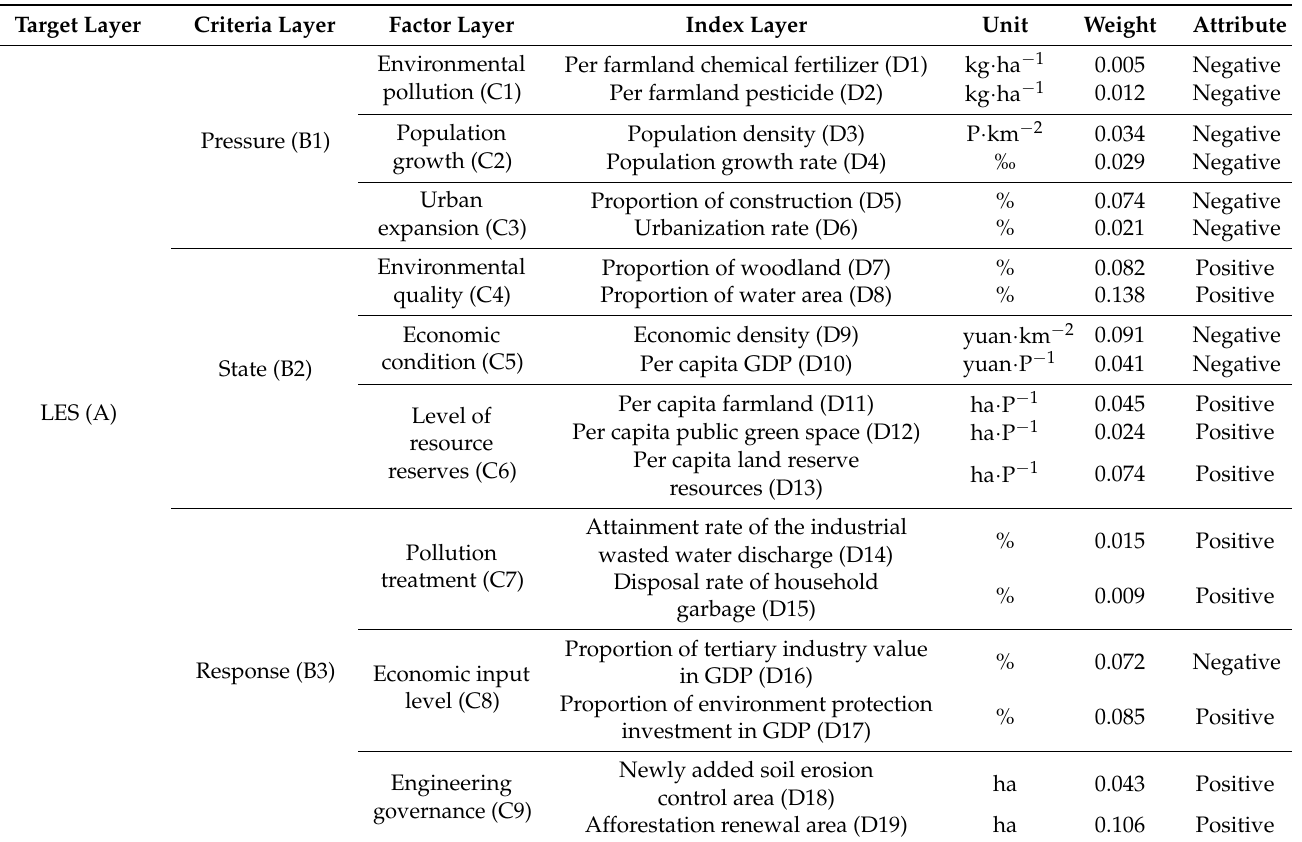
Table 2. Index system of LES